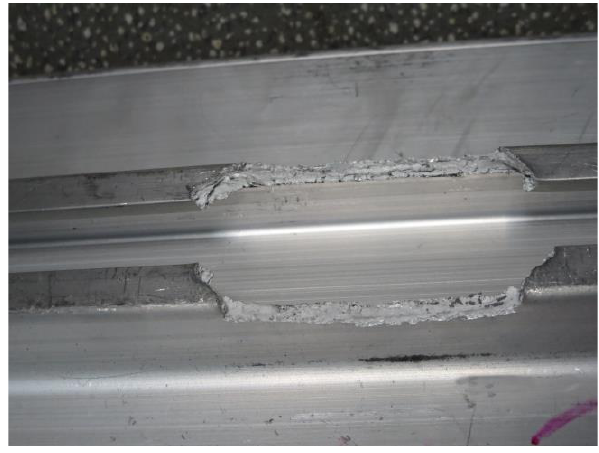
Figure 13. Fatigue fracture profile of a structural component.